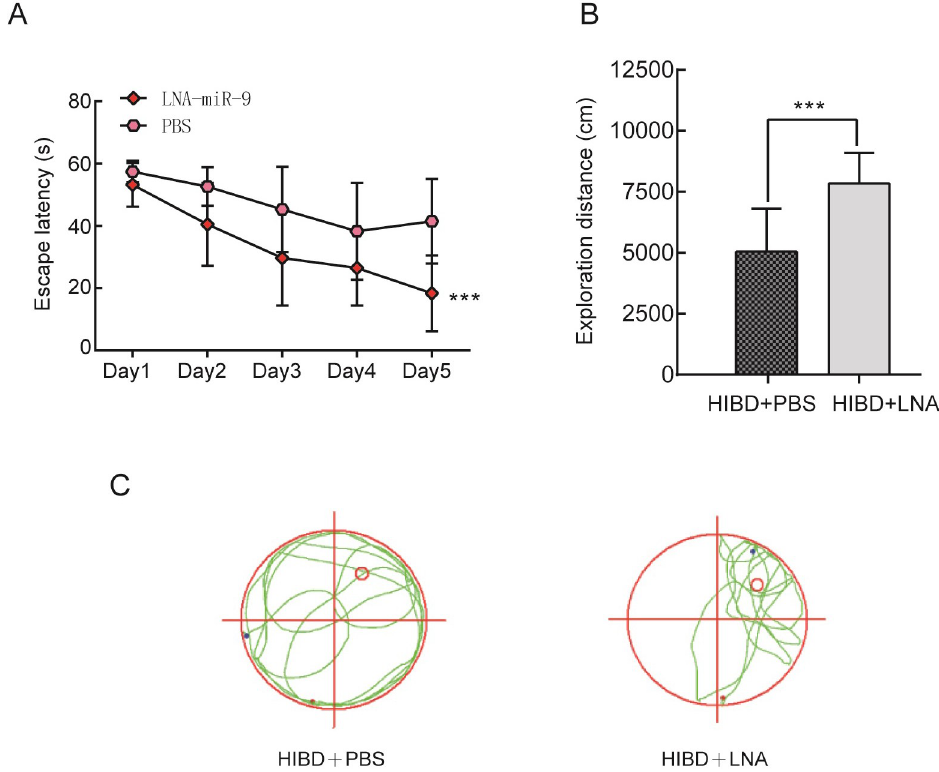
Fig 5. LNA-miR-9 attenuated learning and memory impairments in HIBD rats. (A) The escape latency (T value) of the rats in the training period. (B) The exploration distance (P value) of the rats in the exploratory trials. (C) The exploration route in the retention trial. ��� P < 0.001 vs HIBD+PBS. N = 10 for Morris water maze analysis.